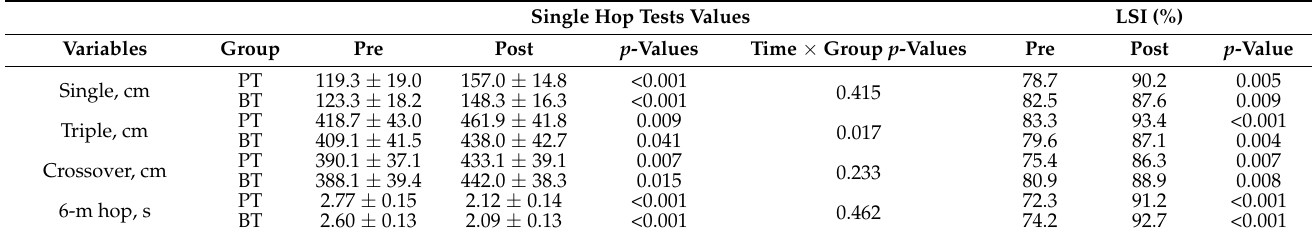
Table 4. Results of the hop tests for Pilates and balance training groups.